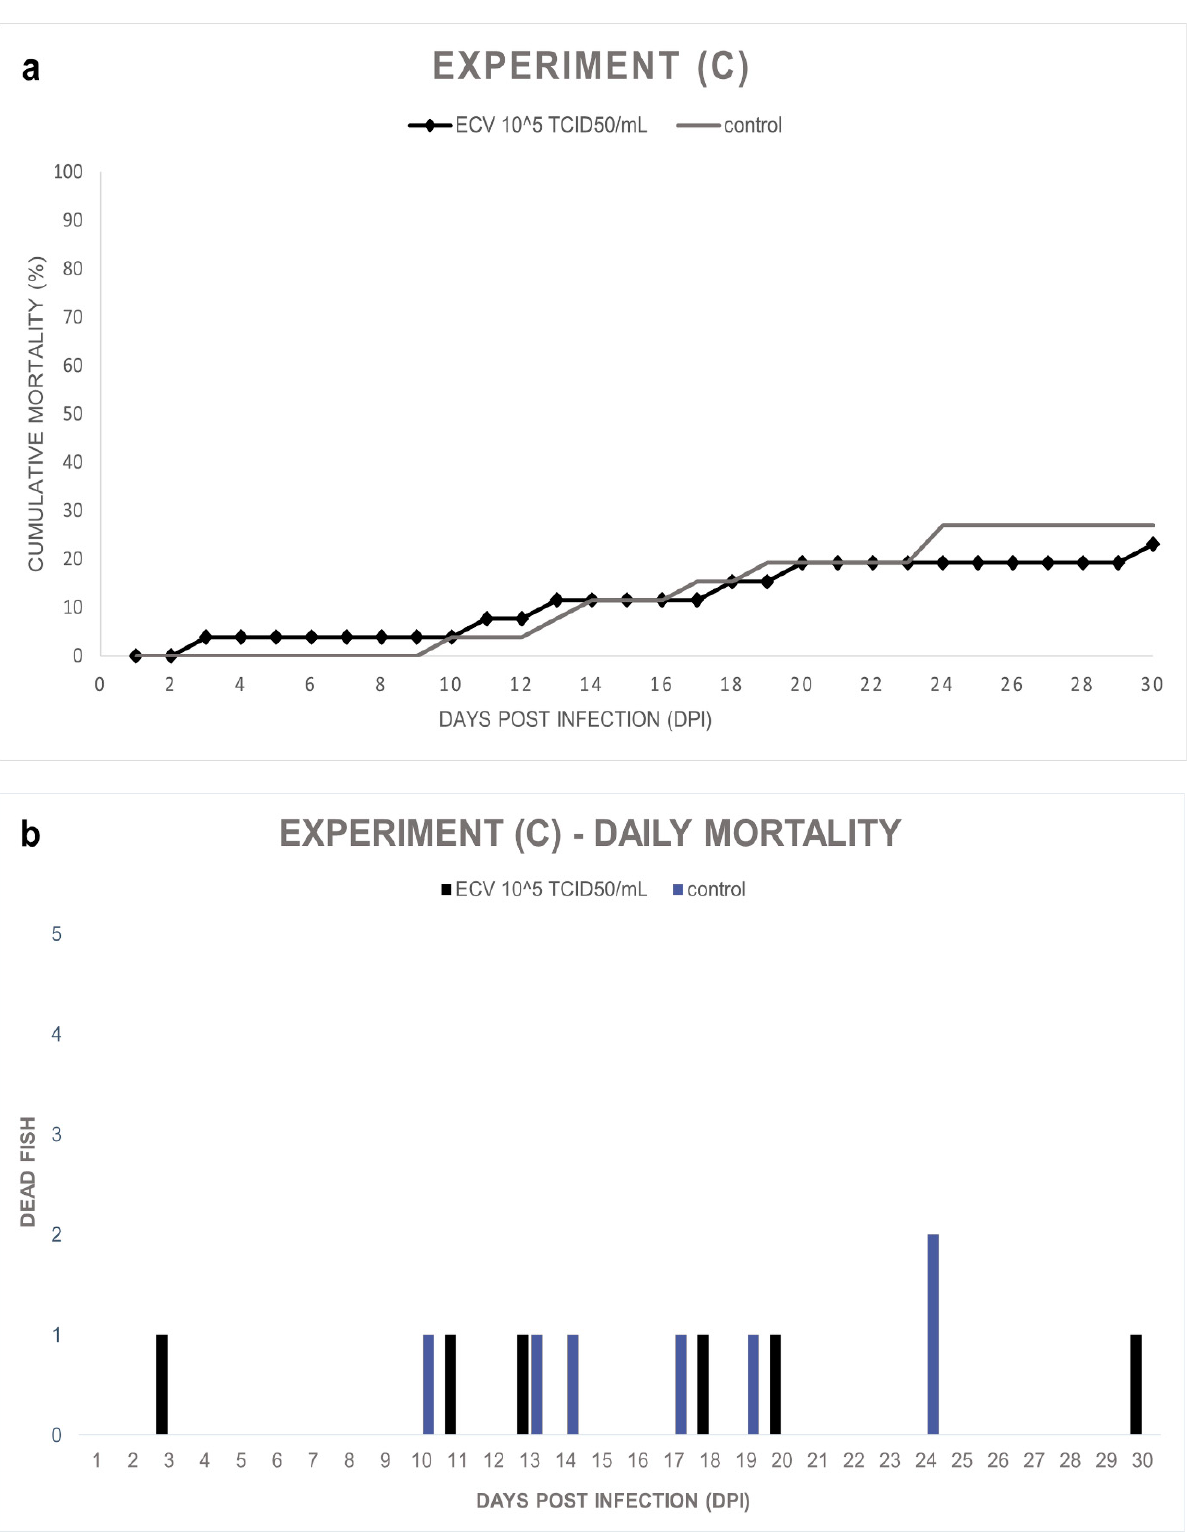
Figure 3. ( a ) Cumulative mortality in Exp. (C), wels catfish ( Silurus glanis ) of 4 months ( n = 26/group) were infected by bath with ECV at 21 ± 0.5 °C for 1 h. Mortality was recorded from 0 to 30 dpi, including the control group. ( b ) Daily mortality in Exp. (C) shows the number of dead fish per day.